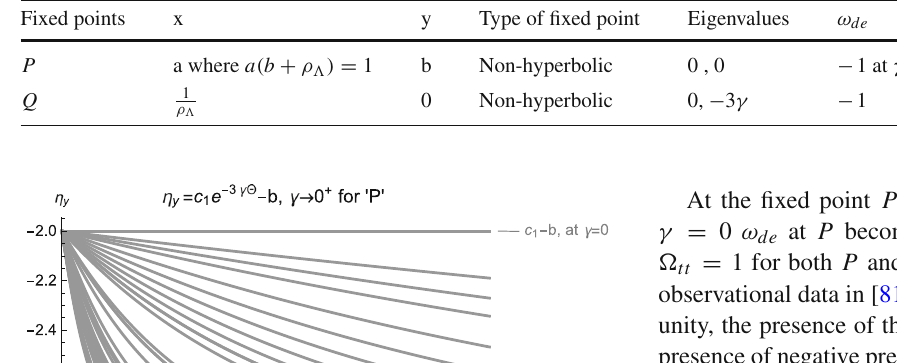
Table 2 Table for Case II ( ˙ G (cid:2)= 0, ρ (cid:2) =constant) Fixed points